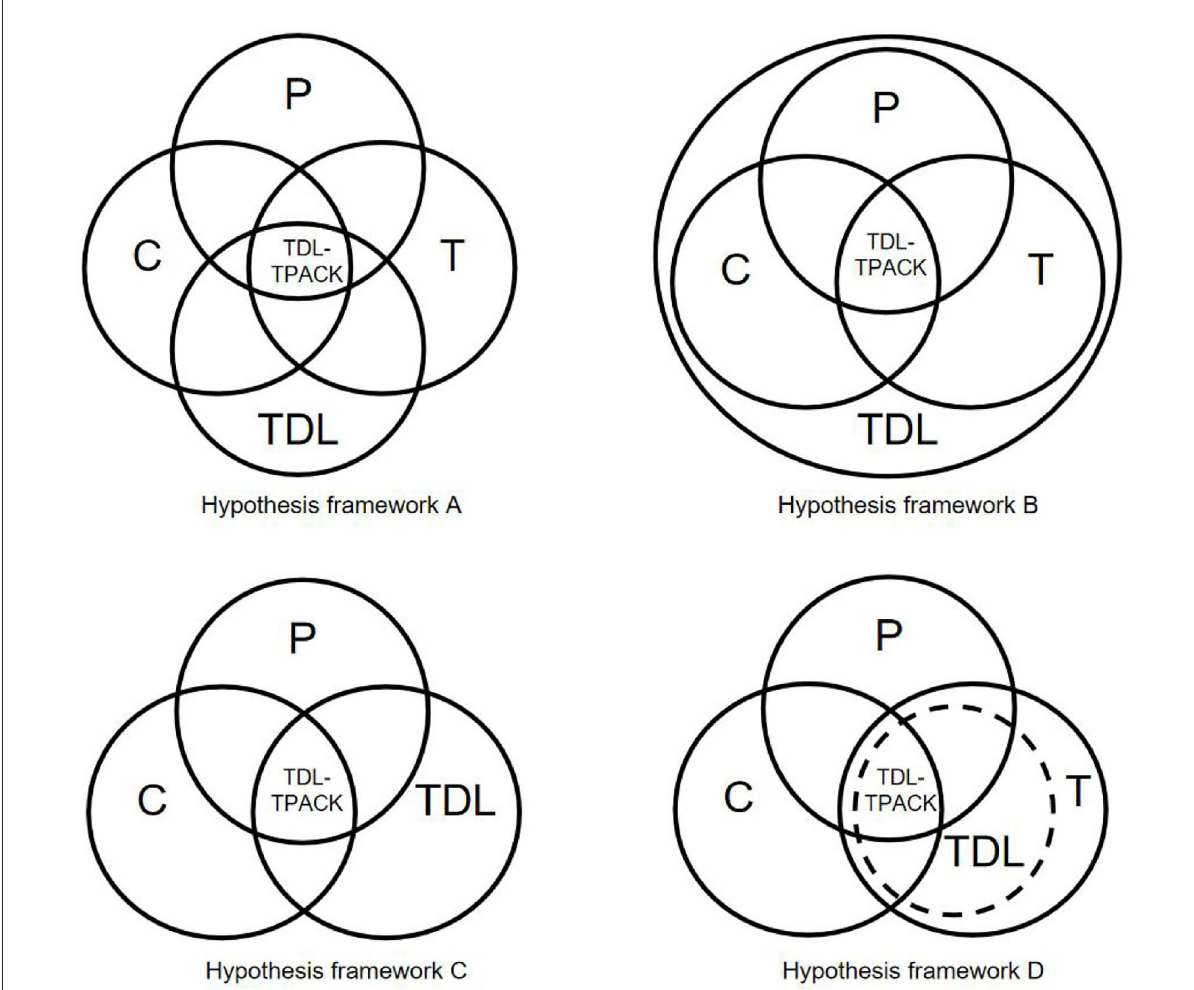
FIGURE2 Different types of hypothesis frameworks of TDL-TPACK based on ORID. Hypothesis framework A—TDL is considered as a separate domain of teacher knowledge. In other words, the TDL is seen as an independent component, and is connected with the original three components